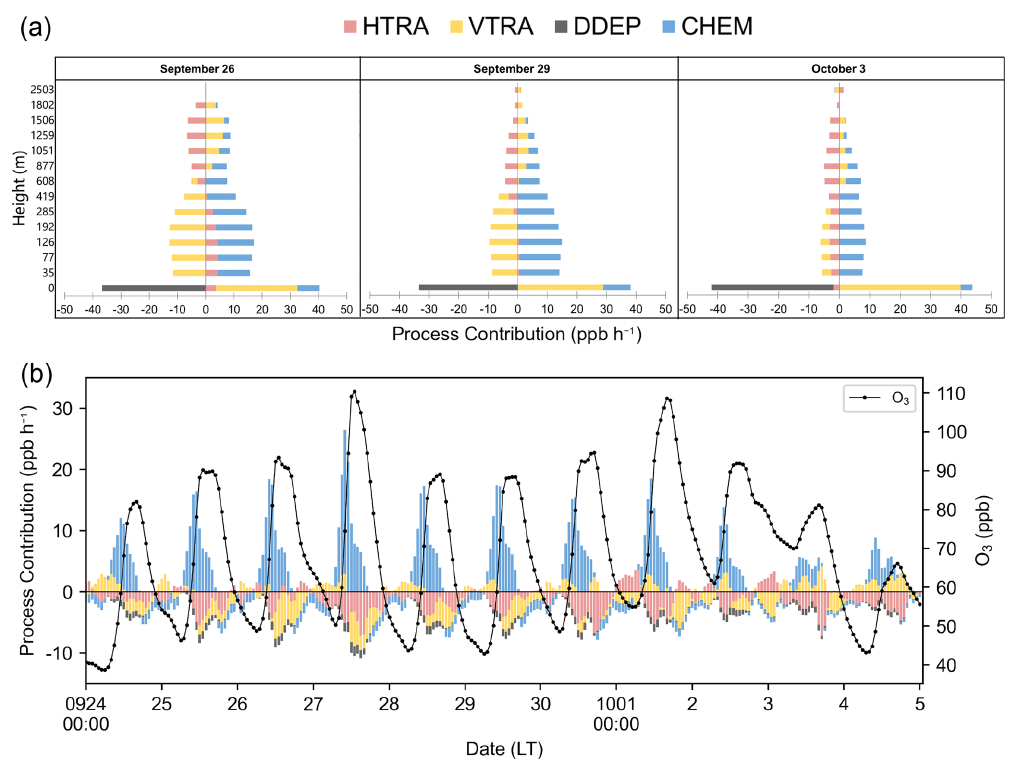
Figure 11. (a) Daytime mean (08:00–18:00) vertical contributions of individual processes to O 3 in the PRD under different periods. (b) Time series of individual processes (the averages of the whole boundary layer) contributing to O 3 in the PRD. The black line (O 3 ) represents the averaged O 3 concentration under the layers below 1260m. Table 3. Daytime (08:00–18:00) and nighttime (19:00–07:00 the next day) mean contributions of individual O 3 processes for layers below 1260m under different